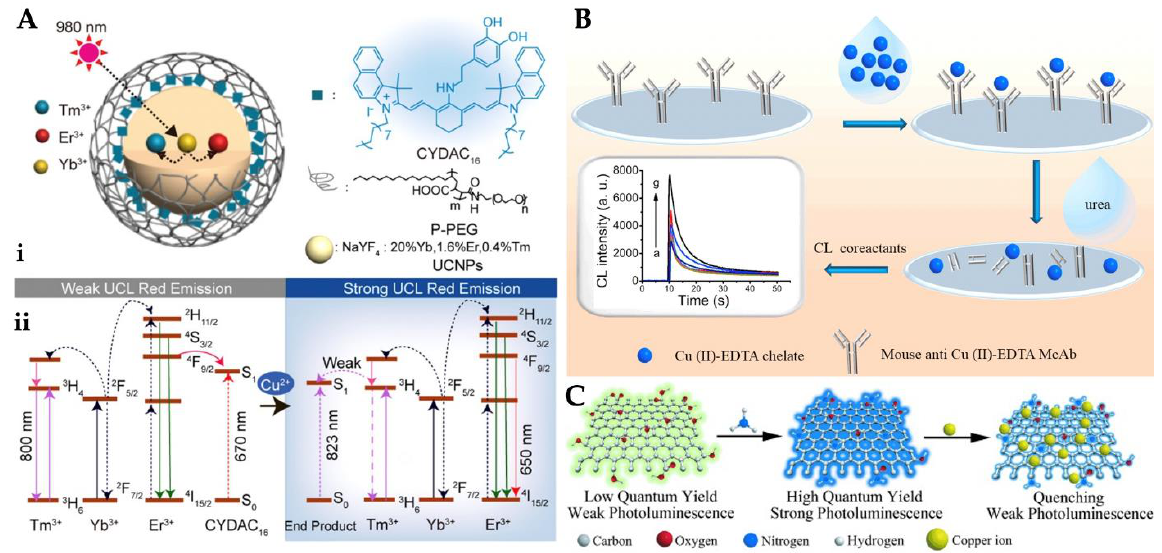
Figure 4. Unification of nanoparticles and CYDAC 16 ( A ), scheme of the protocol for Cu 2+ ion detec- tion ( B ) and representation of amino-functionalized quantum dots and their quenching by Cu 2+ ion ( C ). Republished with permission from [109,115,116].